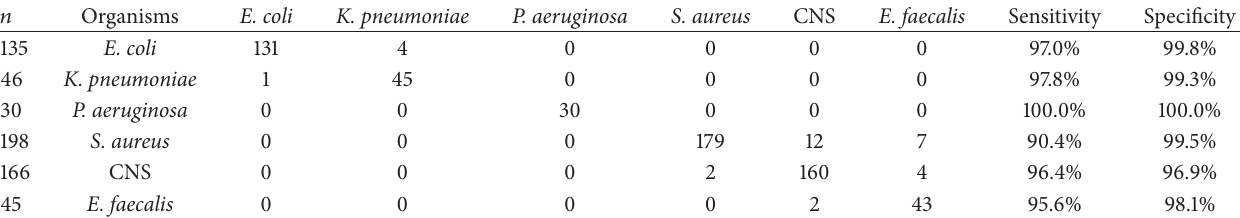
Table 2: Results of the training set for the sensitivity and specificity for each of the target organisms based on transmission data only. 𝑛